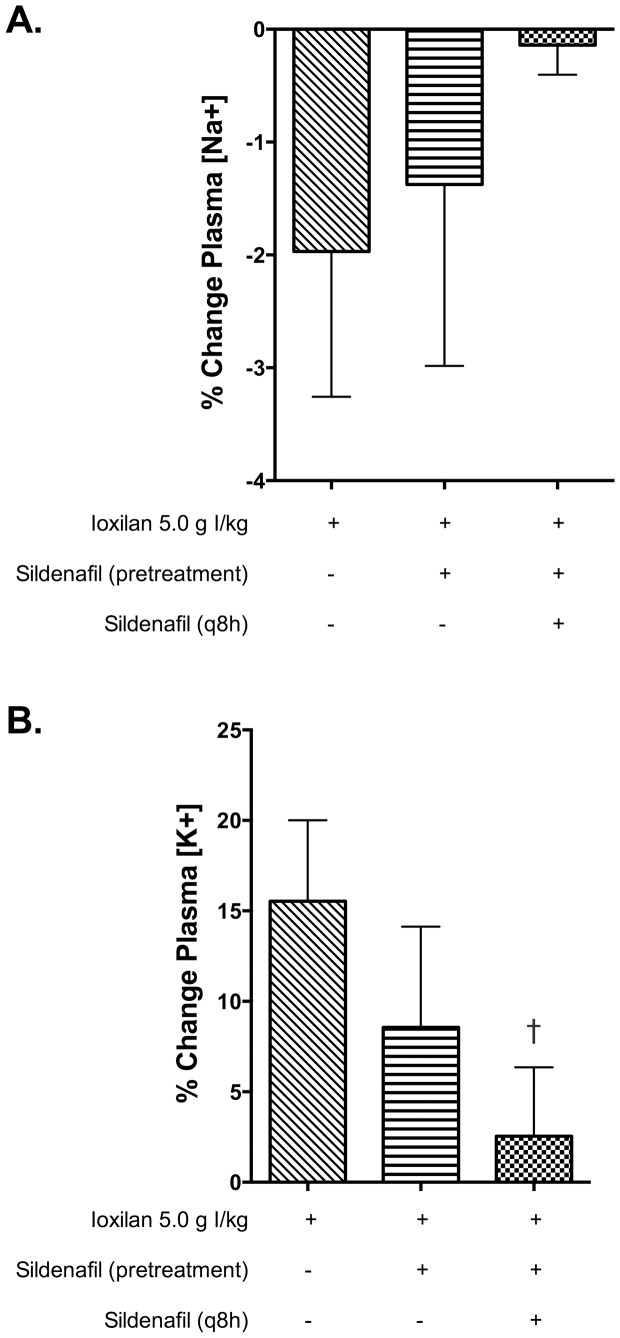
Repeated treatment with sildenafil citrate prevents hyponatremia and hyperkalemia in animals exposed to CM.(A) Percent change (t = 0 vs. 48 h) in plasma Na+ concentrations in animals administered intravenous ioxilan (5.0 g I/kg) with/without simultaneous sildenafil therapy. (B) Percent change (t = 0 vs. 48 h) in plasma K+ concentrations in animals administered intravenous ioxilan (5.0 g I/kg) with/without simultaneous sildenafil therapy. Values are presented as mean ± SEM; n = 3–5. † indicates p<0.05 versus 5.0 g I/kg by one-way ANOVA and Dunnett's multiple comparisons test.